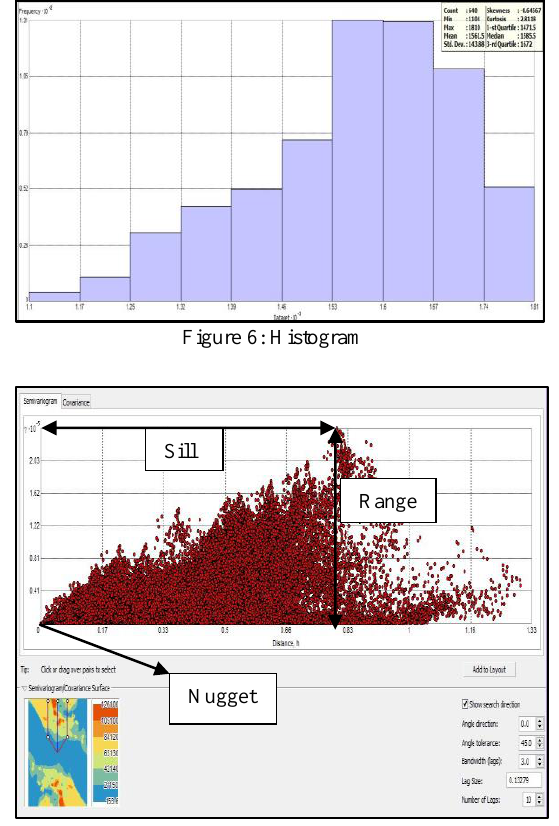
Figure 7: Semi-variogram in North-South